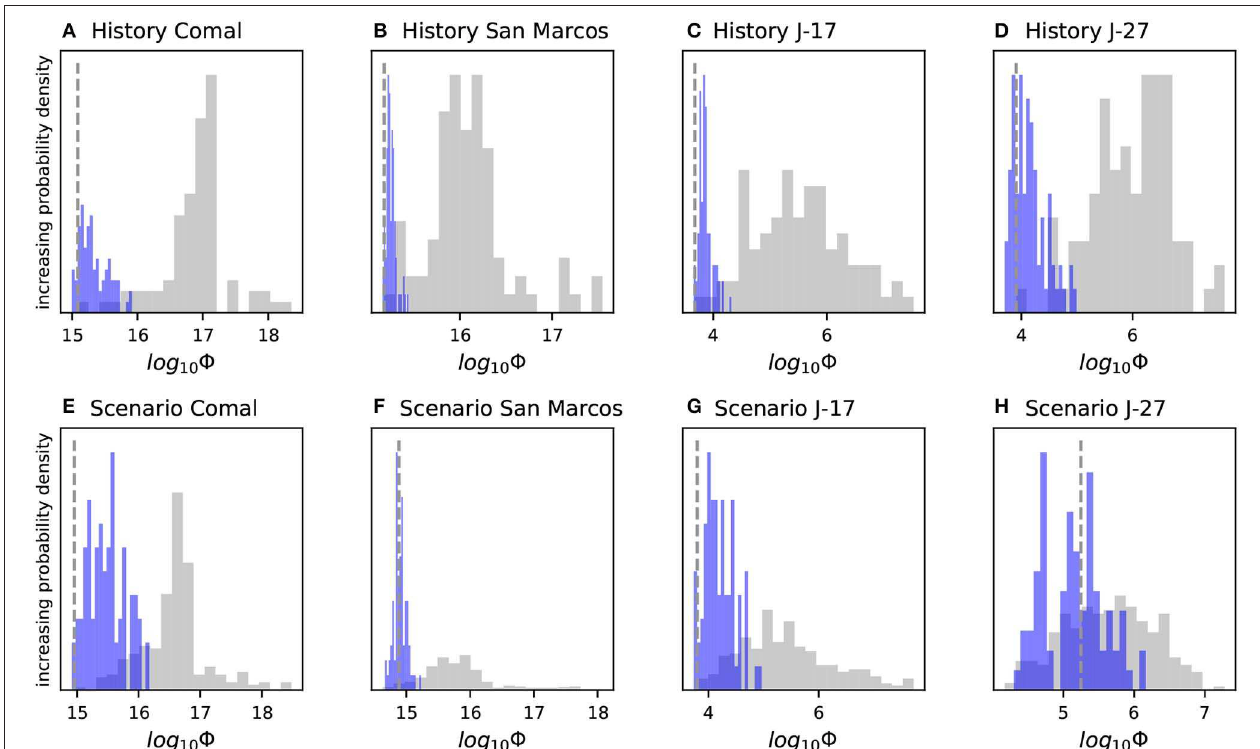
FIGURE 4 | Prior (gray) and posterior (blue) unweighted sum of squared residual (i.e., 8 ) histograms for both history-matching and scenario simulations at the four locations of primary interest to groundwater resource managers. The vertical dashed gray line marks the 8 yielded by the existing model of Liu et al. (2017). Several posterior realizations better reproduce the observed series than the existing model; the history-matching simulation ensemble is more tightly clustered around the minimum 8